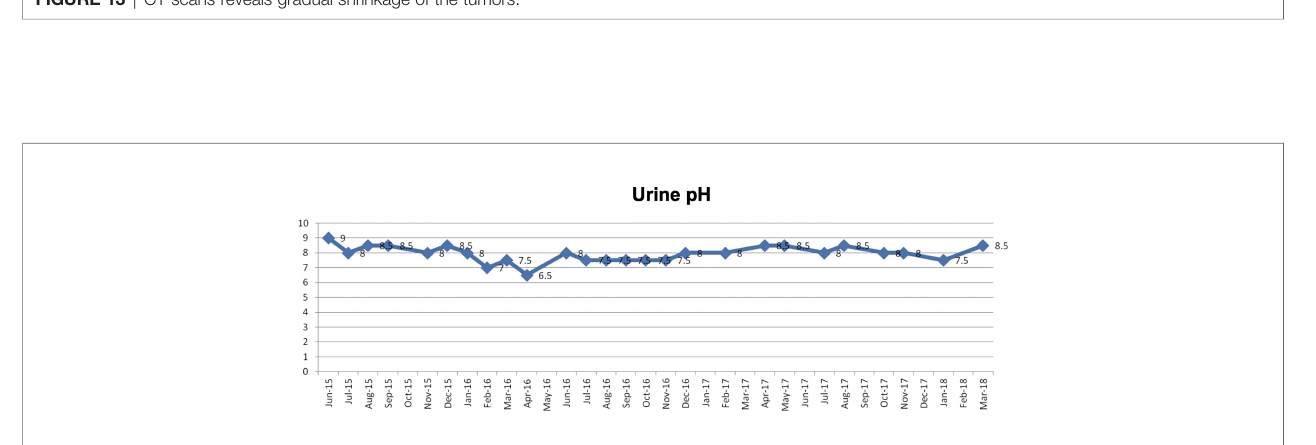
FIGURE 14 | Her urine pH levels are